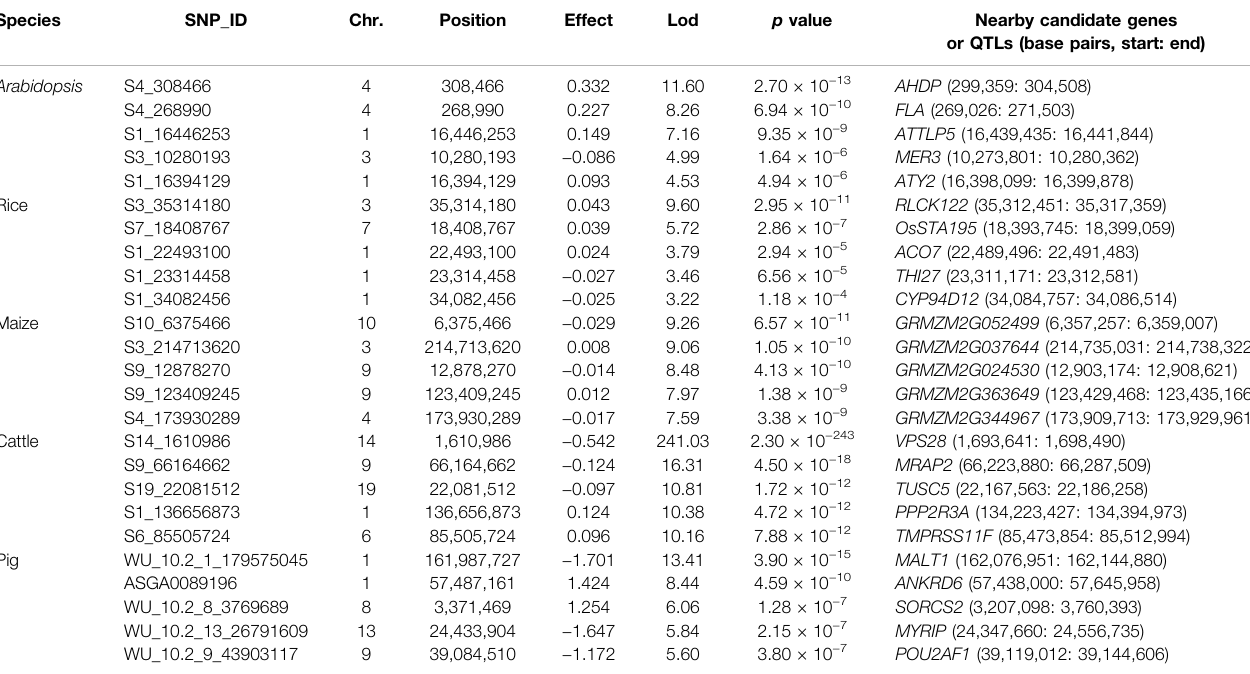
TABLE 3 | Top fi ve associated SNPs identi fi ed by ScoreEB on quantitative traits in Arabidopsis , rice, maize, cattle and pig. Species SNP_ID Chr. Position Effect Lod p value Nearby candidate genes